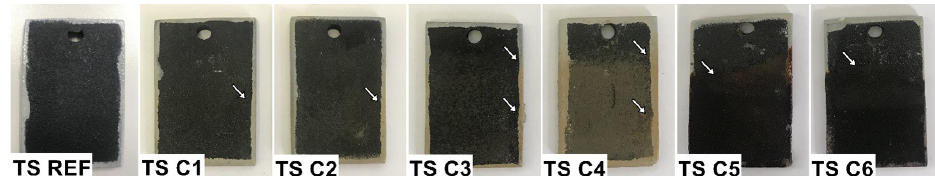
O coating by thermal spray (TS) after immersion 2 5